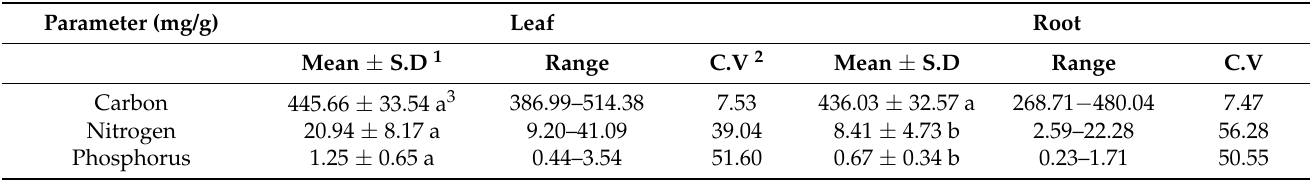
Table 1. The content and distribution characteristics of carbon, nitrogen and phosphorus in leaves and roots of shrubs. Parameter (mg/g)